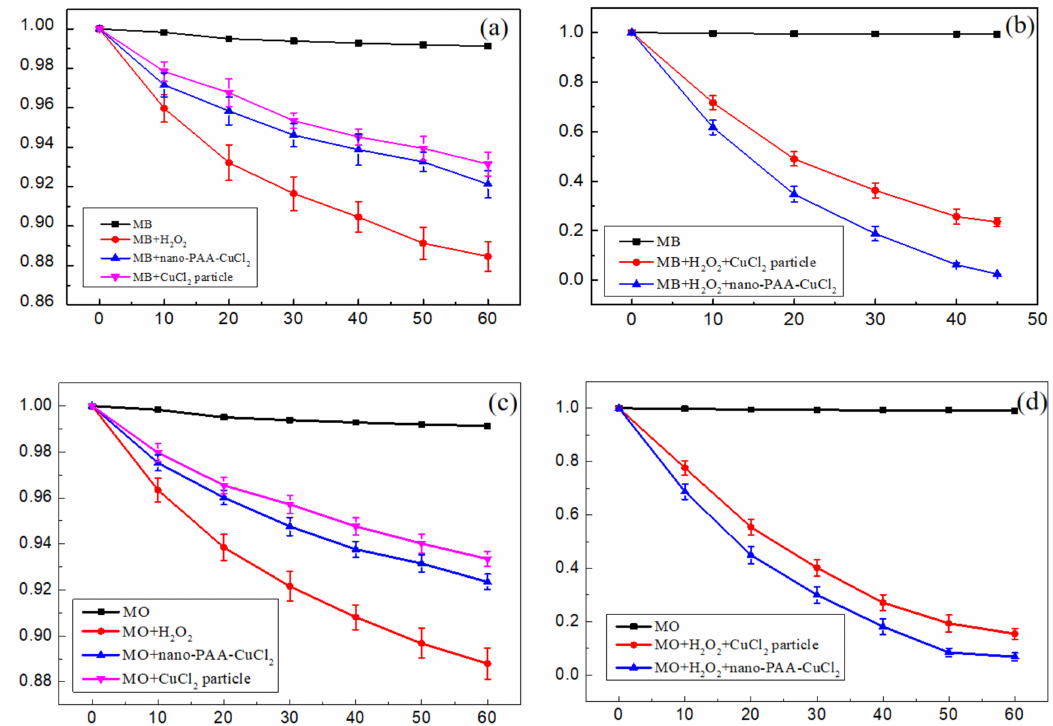
Figure 4. Degradation of MB and MO solution treated with different processes: ( a ) H 2 O 2 , nano-PAA-CuCl 2 composite and CuCl 2 particle in MB solution, ( b ) CuCl 2 particle/H 2 O 2 and nano-PAA-CuCl 2 composite/H 2 O 2 in MB solution, ( c ) H 2 O 2 , nano-PAA-CuCl 2 composite and CuCl 2 particle in MO solution, ( d ) CuCl 2 particle/H 2 O 2 and nano-PAA-CuCl 2 composite/H 2 O 2 in MO